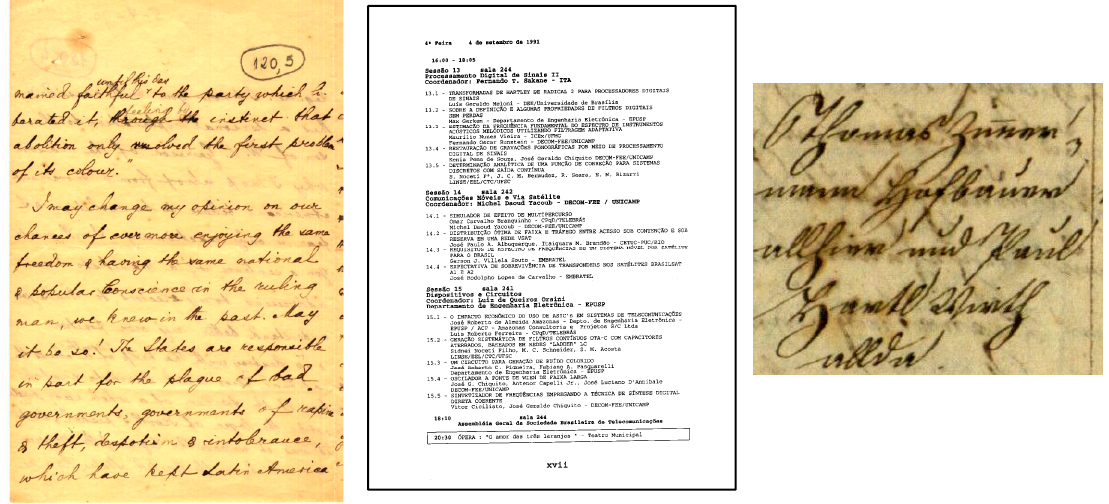
Figure 1. Images with back-to-front interference from the three test sets used in this paper: Nabuco bequest ( left ), LiveMemory ( center ) and DIBCO ( right) .